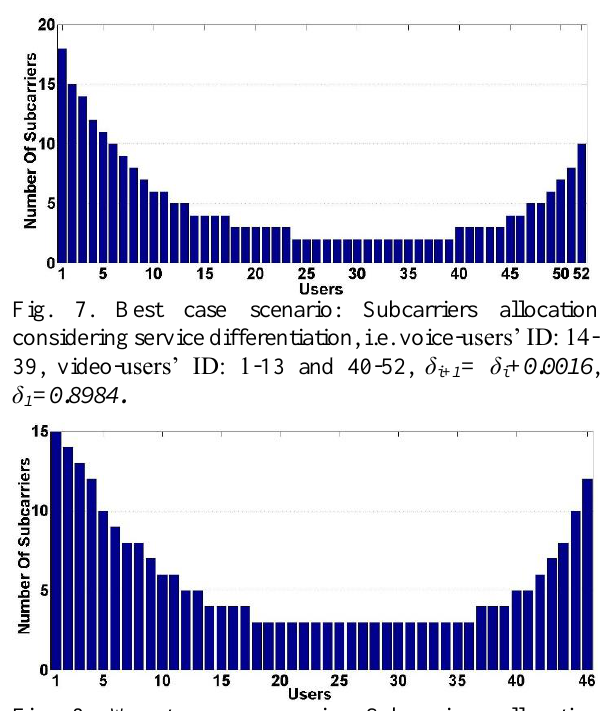
Fig. 8. Worst case scenario: Subcarriers